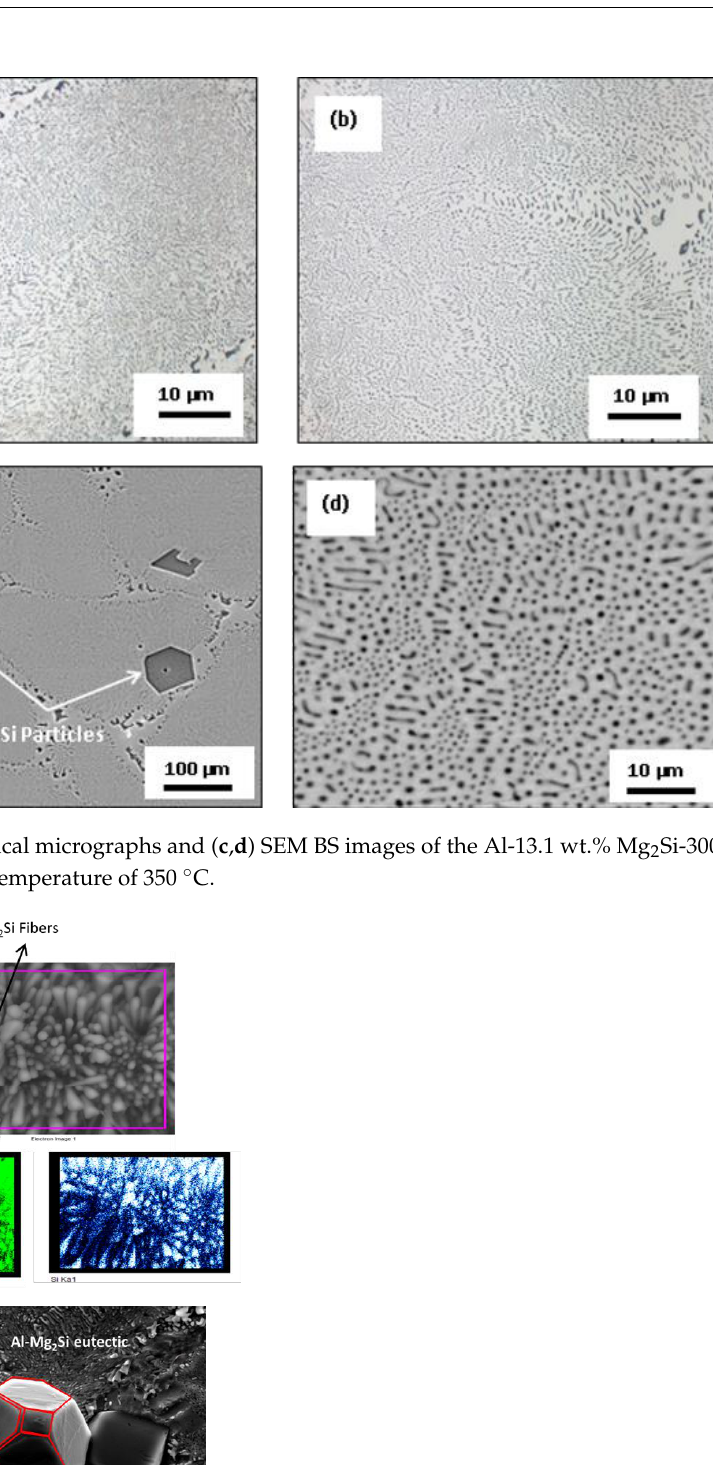
Figure 7. ( a , b ) SEM backscattered (BS) image and corresponding EDS elemental maps from the se- lected region for the Al-13.1 wt.% Mg 2 Si alloy showing the presence of Al, Mg and Si.